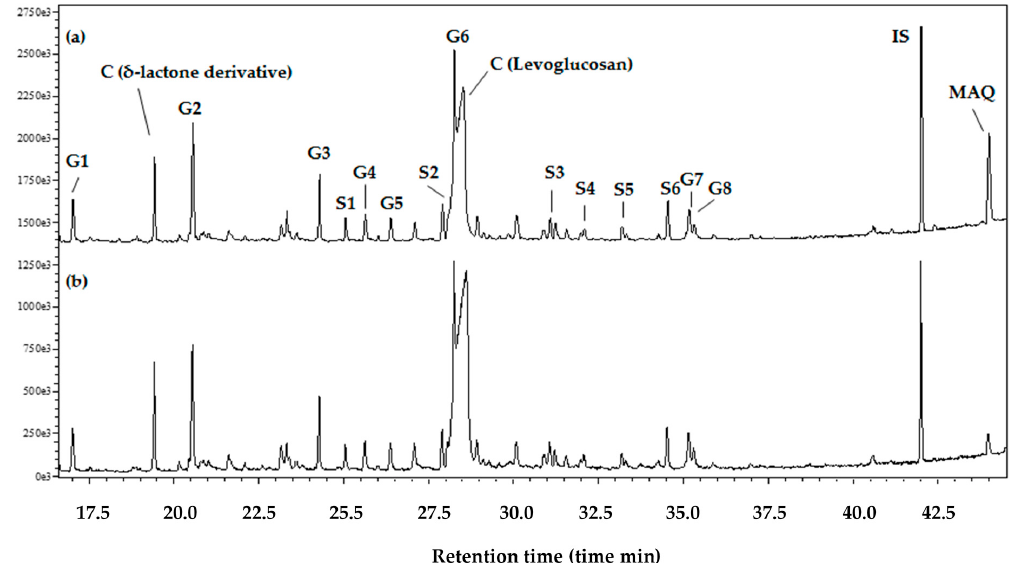
Figure 2. Pyrogram obtained in the Py-GC/MS of T. grandis heartwood ( a ) and chloroform-extracted residues ( b ). Legends: IS = internal standard (n -eicosane ); G1 = guaiacol; G2 = 4-methylguaiacol; G3 = 4-vinylguaiacol; G4 = eugenol; G5 = vanillin; G6 = trans -isoeugenol; G7 = coniferaldehyde; G8 = trans- coniferyl alcohol; S1 = syringol; S2 = 4-methylsyringol; S3 = 4-vinylsyringol; S4 = 4-allylsyringol; S5 = syringaldehyde; S6 = trans -4-propenylsyringol; G1–G8 = pyrolysis products from guaiacyl lignin unit; S1–S6 = pyrolysis products from syringyl lignin unit; C = pyrolysis products from carbohydrate; and MAQ = 2-methylanthraquinone.